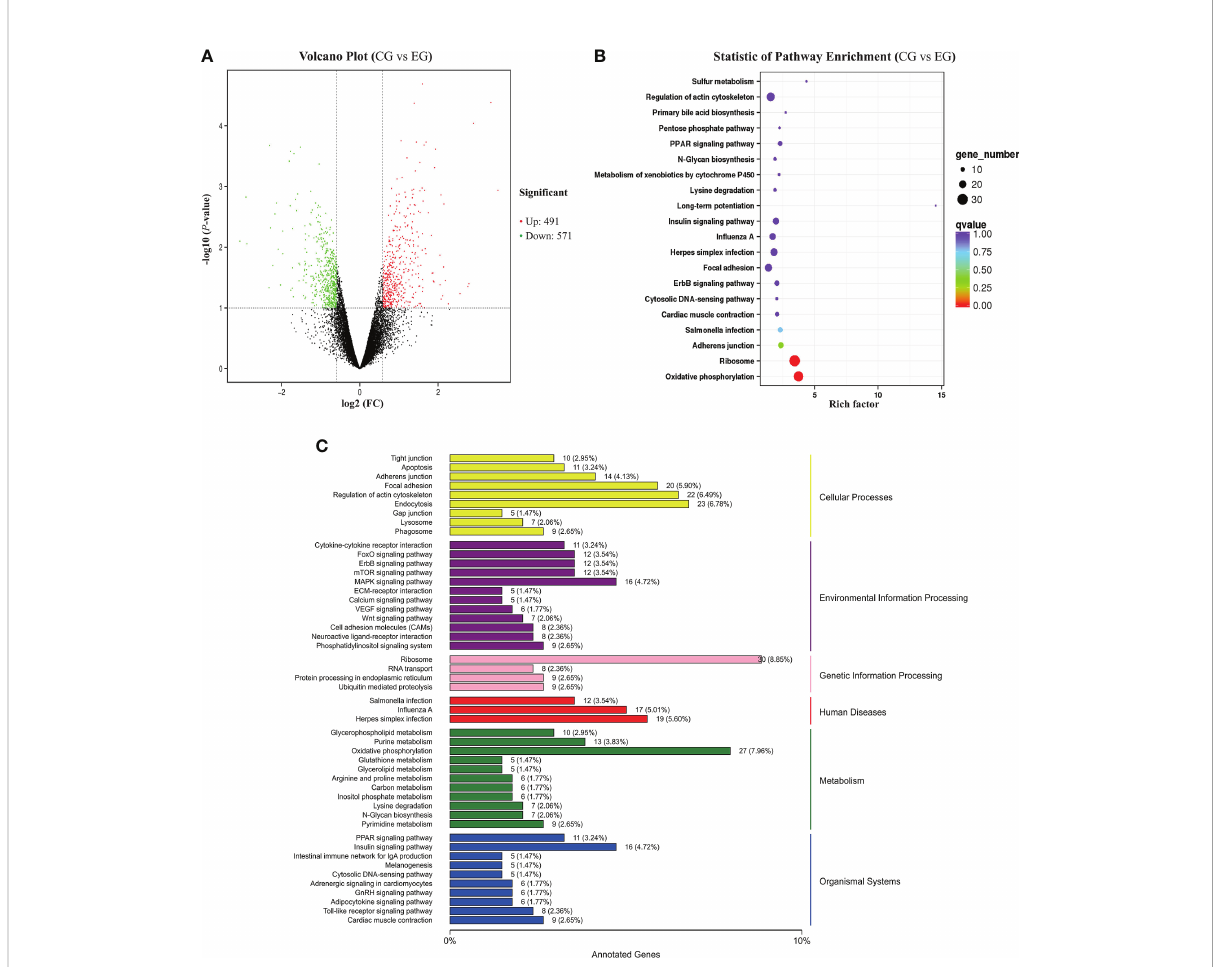
FIGURE 4 RNA-seq analysis of the jejunum tissue of the ducks (CG vs. EG). CG, control group (non-challenged with pathogenic ( E ) coli O88); EG, experiment group (challenged with pathogenic ( E ) coli O88). (A) Volcano plot of differentially expressed genes. The x -axis shows the log2 (FC) of DEGs between the two groups, and the y -axis indicates the negative logarithm of the P -value; each point in the volcanic map represents a gene; red represents increased expression, while green represents decreased expression. (B) Dot plot of the KEGG pathway enrichment analysis of differentially expressed genes. (C) KEGG classi fi cation of differentially expressed genes. The vertical axis is the name of the KEGG pathway. The horizontal axis is the number of genes and the proportion of genes from the total annotated genes.